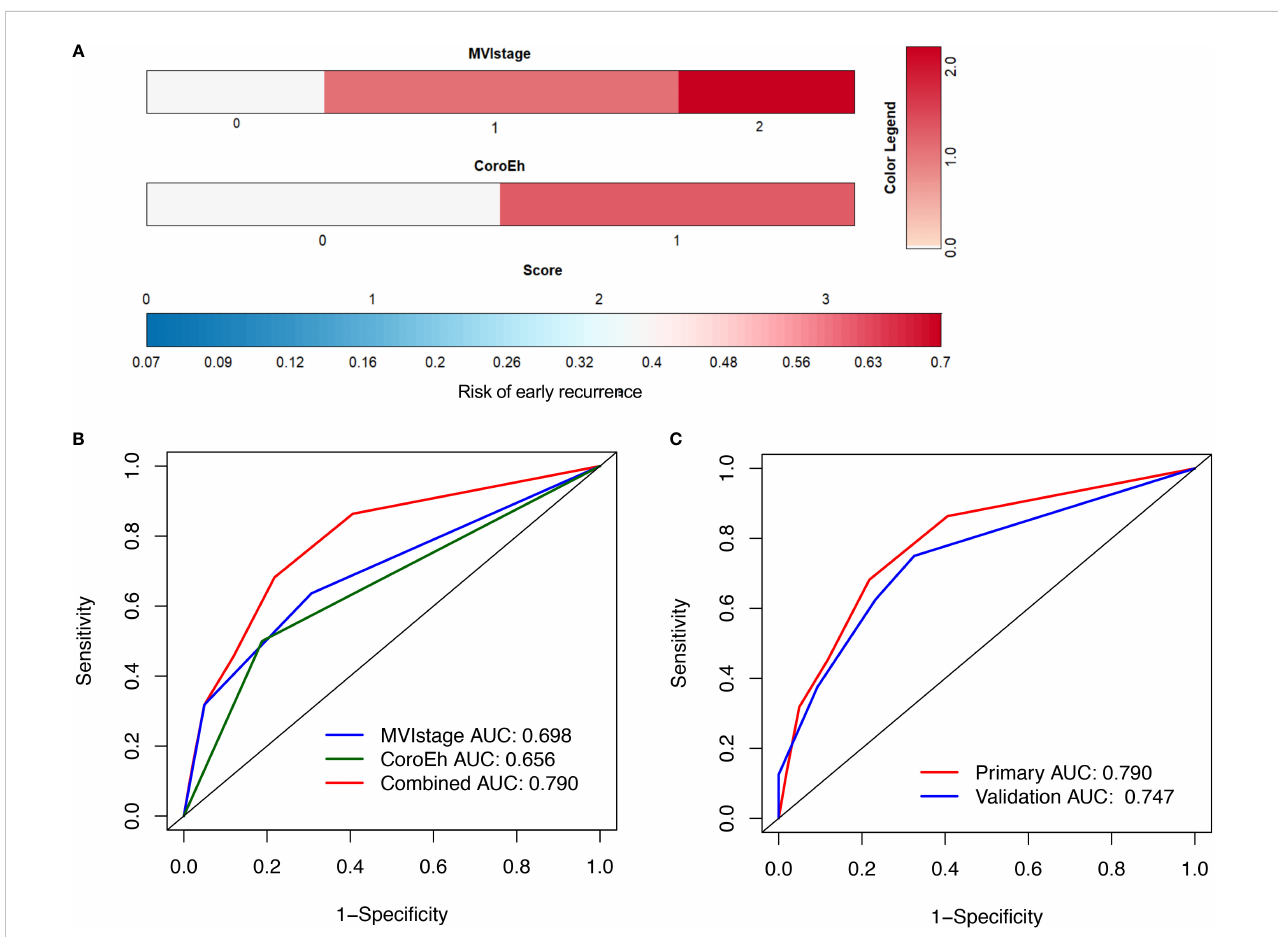
FIGURE 3 Combined factors for predicting risk of early HCC recurrence. (A) nomogram model incorporates the microvascular invasion (MVI) stage and corona enhancement (CoroEh); the sum is used for predicting early recurrence. (B) Receiver Operating Characteristic (ROC) curve shows the predictive value of the nomogram model in the primary cohort. The combined model (red line) shows better predictive ability than either single factor. The area under the ROC curve (AUC) of the combined model was 0.790, with 78.2% speci fi city and 68.2% sensitivity. (C) The predictive value of the combined model was comparable in the validation cohort; the AUC was 0.747, with 67.4% speci fi city, and 75.0%